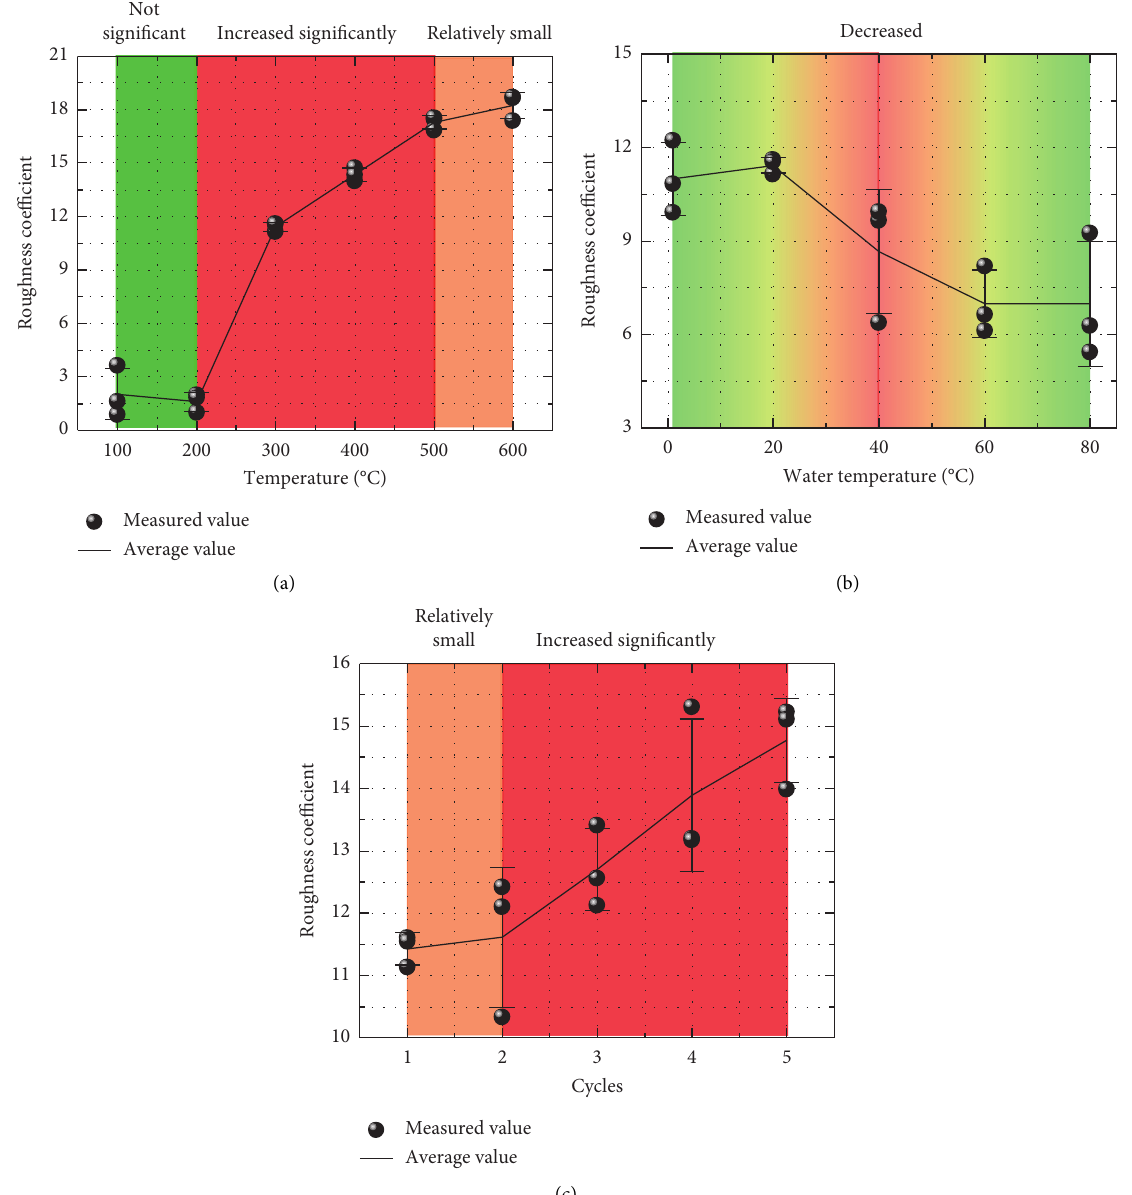
Figure 9: Roughness coefficient of the split surface of specimens under different conditions of water cooling at high temperatures. (a) HDR temperature. (b) Water temperature. (c) The number of heating-cooling